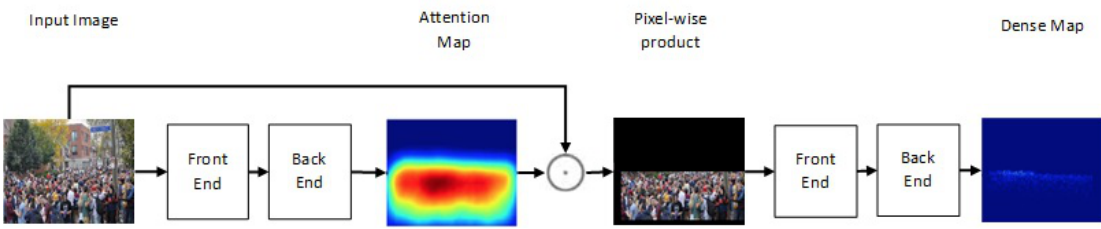
Figure 6. Structure of ADCrowdNet.